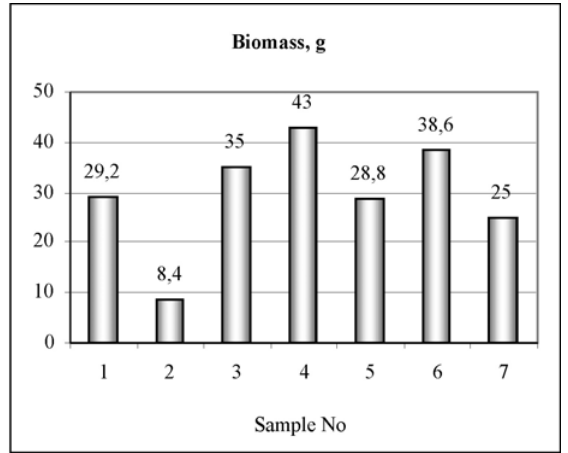
Fig 5. Lettuce biomass in substrates of different composi- tion: 1 – peat substrate; 2 – soil; 3 – soil and sewage sludge 3:1; 4 – soil and sewage sludge 3:1 and 1,0 g